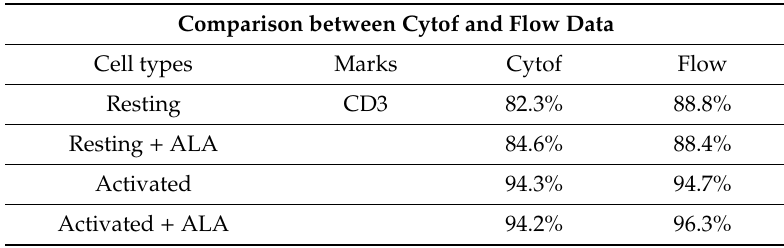
Table A1. Comparison between the data obtained from CyTOF and Flow cytometry.